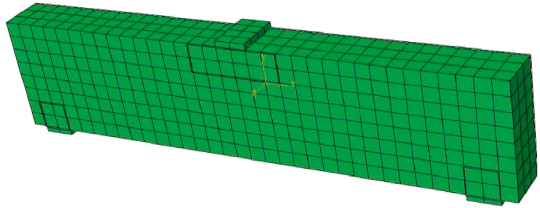
Figure 8: FEM model of composite slab. Table 3: Comparisons of shear